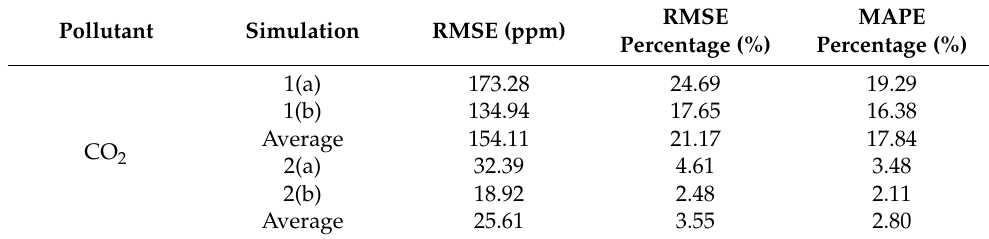
Table 8. CO 2 concentration test and prediction tool RMSE and MAPE